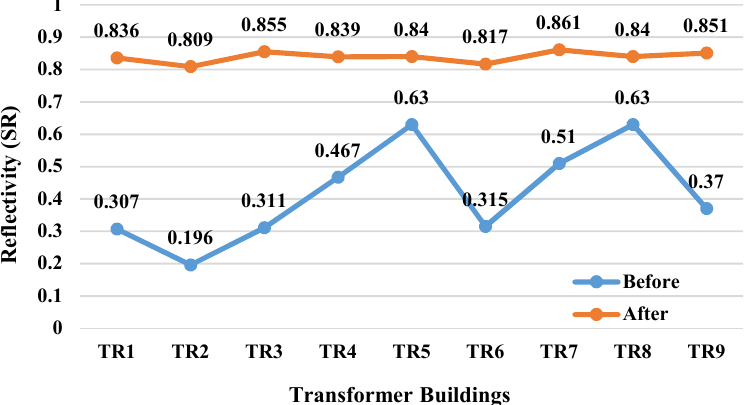
Figure 3. Reflectivity valued before and after the reflective coating.